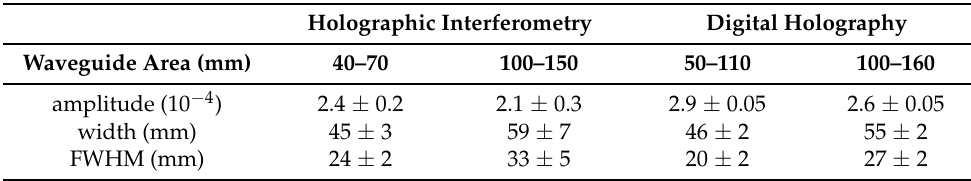
Figure 3. ( a ) Stitching of four consecutive holographic interferograms demonstrating formation of strain soliton from the shock wave in the polystyrene rod at the distance of 40–70 mm from the rod input. The frame size is 30 mm, the size of the field of view obtained by stitching is 70 mm. ( b ) Stitching of three consecutive holographic interferograms showing soliton with oscillating tail in the polystyrene bar at the distance of 100–150 mm from the bar input. The frame size is 50 mm, the size of the field of view obtained by stitching is 100 mm. Stitching lines are indicated on the interferograms with white ( a ) and black ( b ) arrows. Fast-decaying short-wavelength oscillations in the graph ( a ) are indicated by yellow arrows. Table 1. Parameters of nonlinear elastic strain waves in different areas of the polystyrene waveguide, determined from graphs in Figures 3 and 4. The error bars were obtained from the analysis of several recorded profiles of strain waves and statistical analysis of these